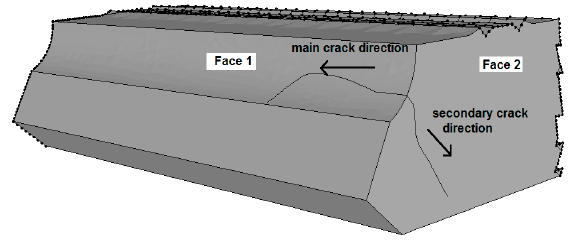
Figure 9. Two leading crack front directions.